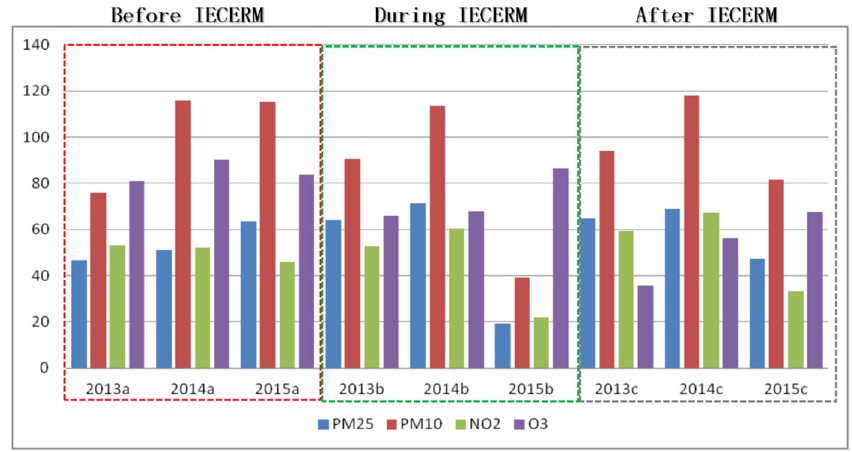
Figure 7. The change trend of pollutants over the same period when before, during, and after the IECERM from 2013 to 2015. Notes: The unit on the y -axis is µ g · m −